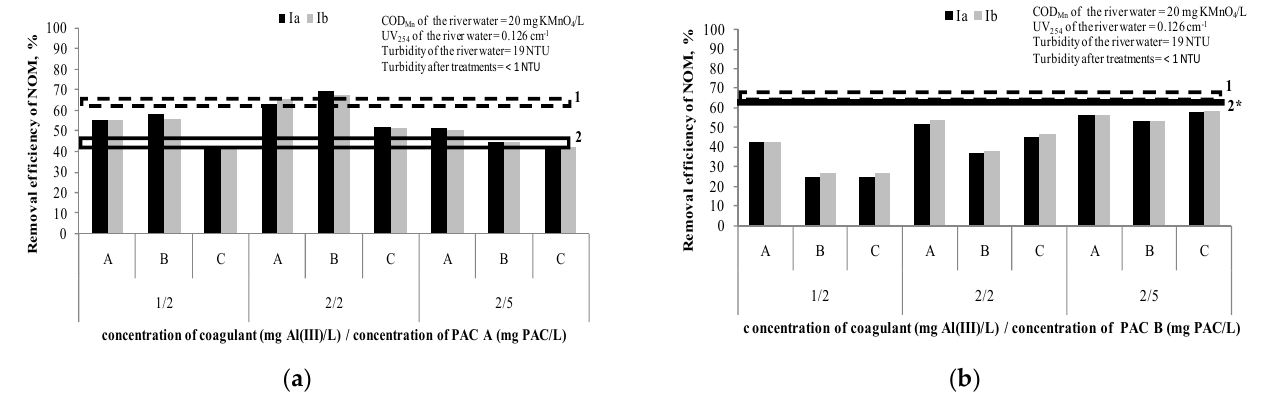
Figure 3. Efficiency of NOM removal using hybrid processes (A, B and C dosing sequences): ( a ) coagulant doses of 1 and 2 mg Al(III)/L and doses of PAC A 2 and 5 mg PAC/L; ( b ) coagulant doses of 1 and 2 mg Al(III)/L and doses of PAC B 2 and 5 mg PAC/L. Note: Ia—removal efficiency (COD Mn ) in experiment; Ib—removal efficiency (COD Mn ) in experiment duplicate; 1 - Dashed line represents removal efficacy of separate C/F/S with coagulant dose range 1–5 mg Al(III)/L (63–66%); 2—Line represents removal efficacy of separate PAC A /S at doses 2 and 5 mg of PAC/L (41% and 47%, respectively); 2*—Line represents removal efficacy of separate PAC B/S at doses 2 and 5 mg of PAC/L (60% and 61%, respectively).